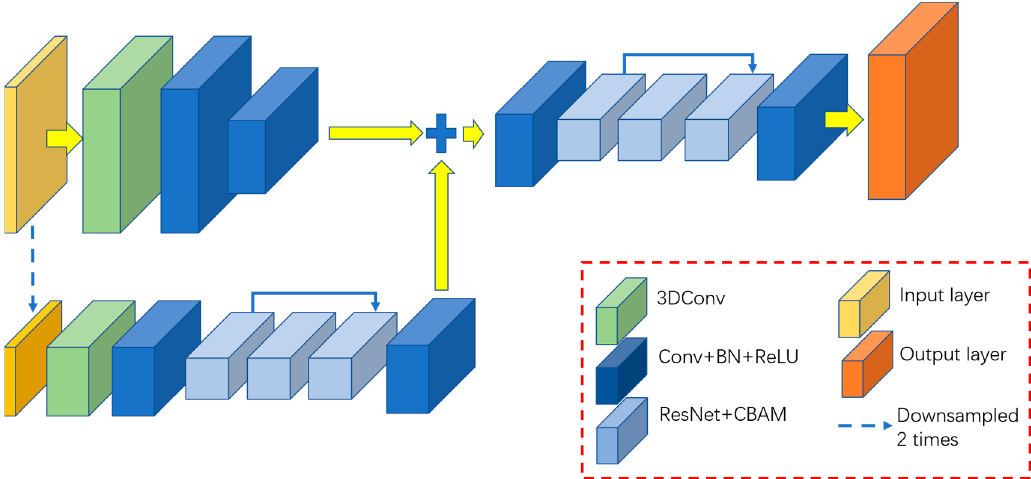
Figure 2. The structure of the dual-scale generator.